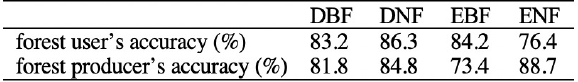
Table2. Forest user's and producer's accuracy for deciduous broadleaf forest (DBF), deciduous needleleaf forest (DNF), evergreen broadleaf forest (EBF), and evergreen needleleaf forest (ENF).